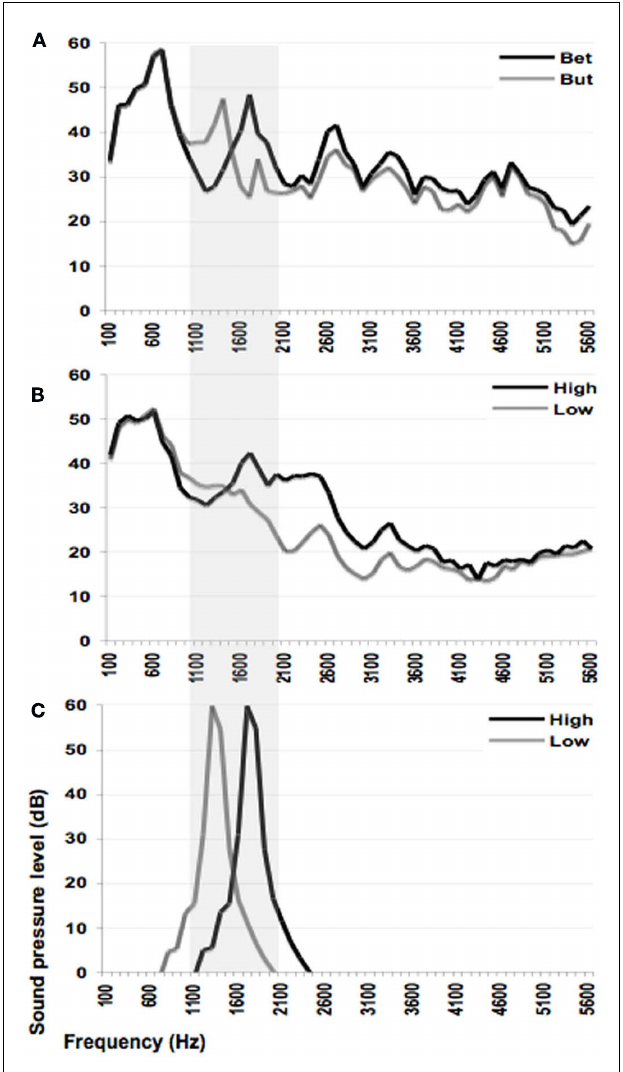
FIGURE 3 | Long-term average spectrum of target stimuli (A), speech contexts (B), and tone contexts (C). The shaded area indicates F2 frequencies critical to distinguishing the speech targets and two context types (speech and tone) in present